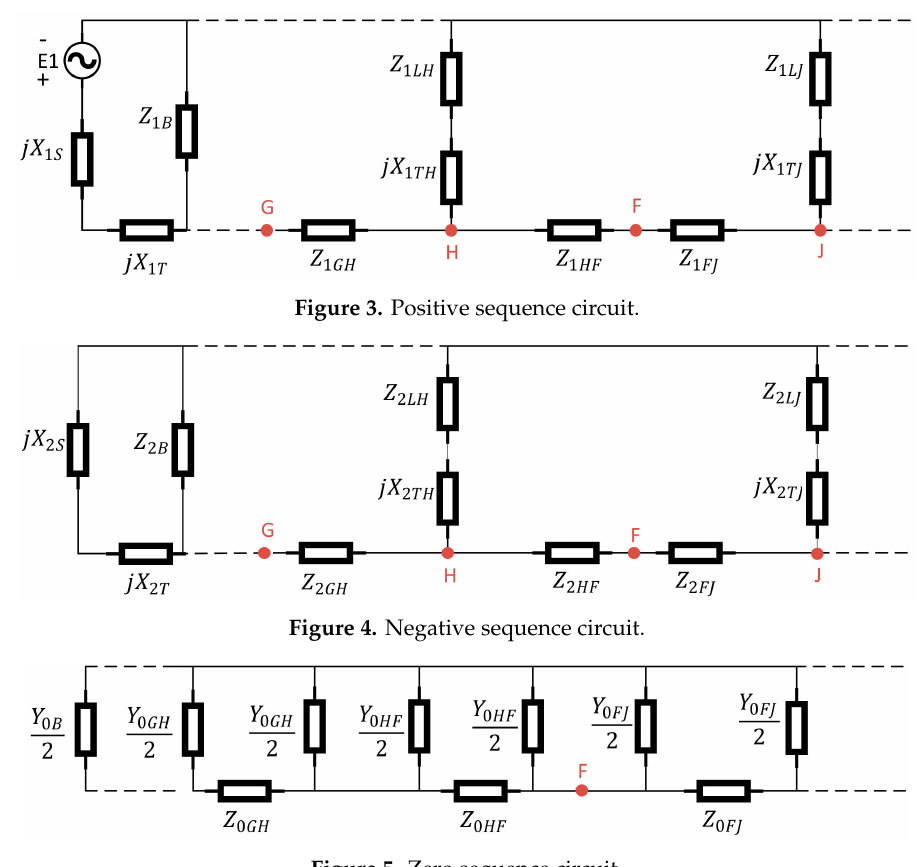
Figure 5. Zero sequence